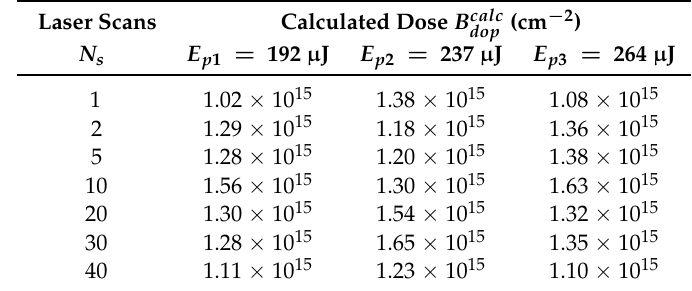
Table 2. Calculated dose B calc , obtained through integration of the (unscaled) secondary ion mass dop spectrometry (SIMS)-measured boron concentration profiles, of areas treated by repeated laser scans for three laser pulse energies E p . No dopant loss (e.g., out-diffusion) occurs, because B calc constant for all combinations of E p and N s